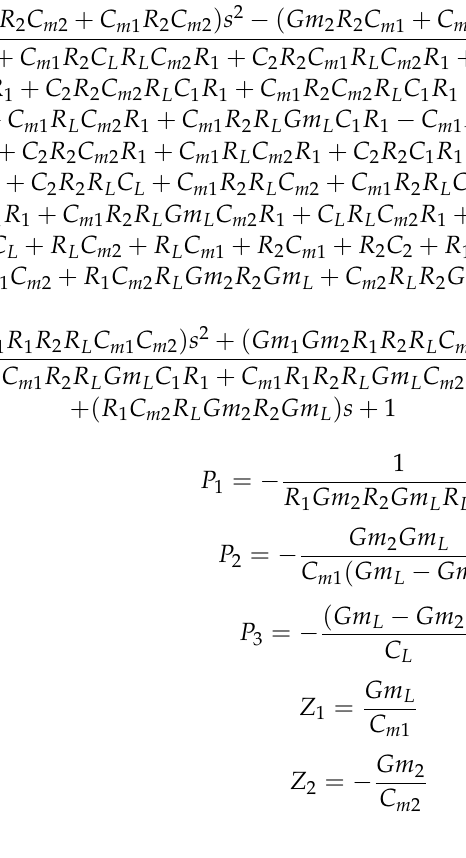
Table 4. Number of terms within simplified symbolic poles/zeroes in Circuit 1.